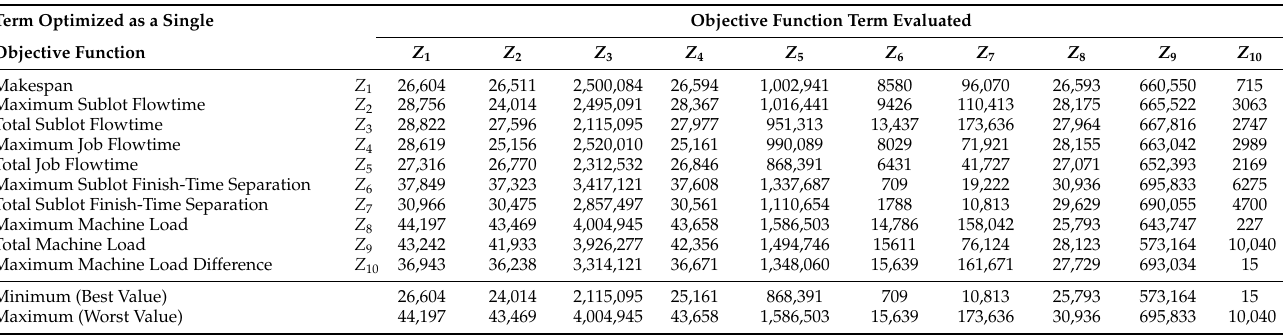
Figure 9. Values of the objective function terms in Problem-1 when only one objective function term is optimized. Table 10. Values of the objective function terms in Problem-4 when only one objective function term is